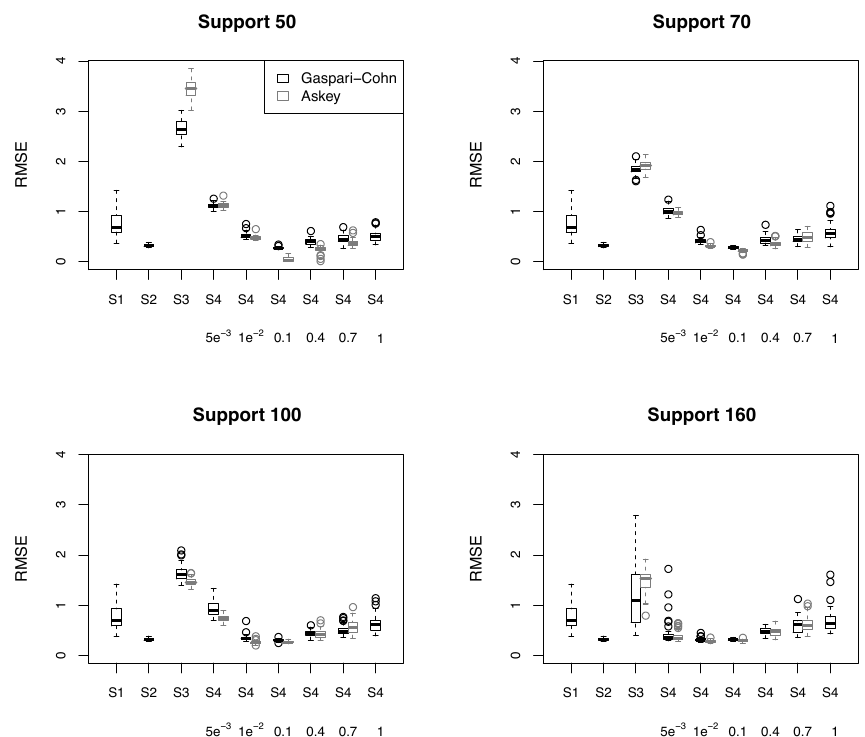
Figure 4. The box plot of RMSE for variable X in the case when the system is only partially observed. Results are shown for different localization strategies. For the definitions of localization strategies S1, S2, S3 and S4, see the text. The title of each panel indicates the localization radius (length of support). The lower and upper bounds of the box respectively give the 25th and 75th percentiles. The thick line going across the interior of the box gives the median. The whisker depends on the interquartile range (IQR), which is precisely equal to the vertical length of the box. The whiskers extend to the extreme values, which are no more than 1.5 IQR from the box. Any values that fall outside of the end points of whiskers are considered outliers, and they are displayed as circles. The numbers below S4 indicate the value of β . There is no box plot for β = 1 for the S4 with the Askey function, since the Askey function is not defined with β = 1 ( | β | ≤ 0 . 79; see Sect.